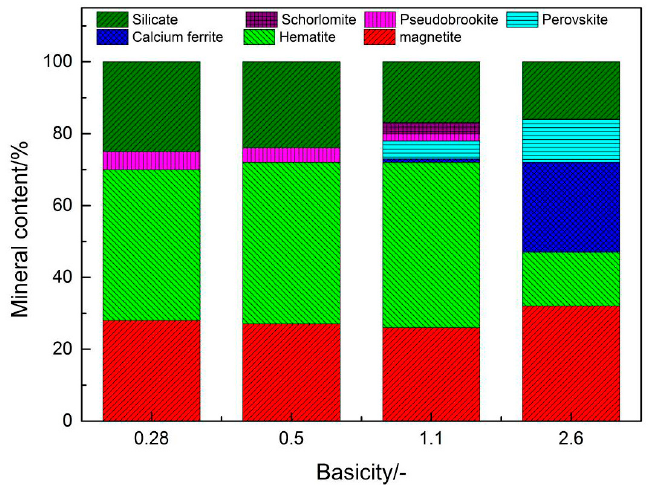
Figure 6. Mineral content of acid, self-fluxing, and high-basicity PVTM sinters.